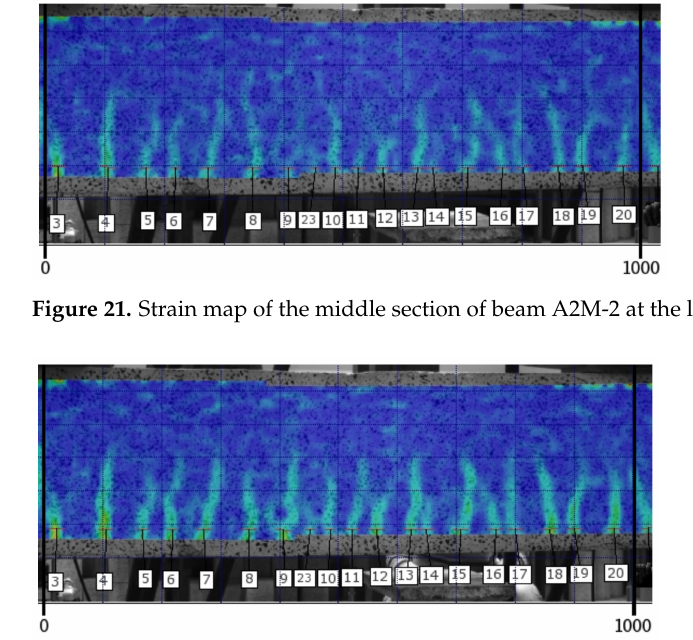
Figure 22. Strain map of the middle section of beam A2M-2 at the load level of